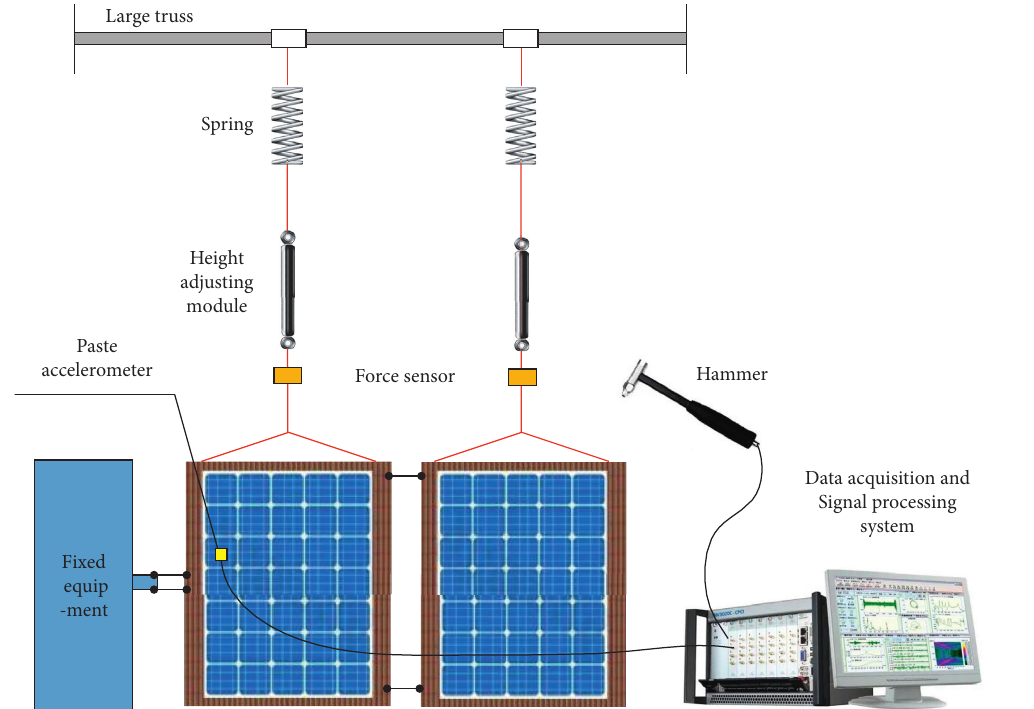
Figure 1: The suspended modal test system of solar arrays.